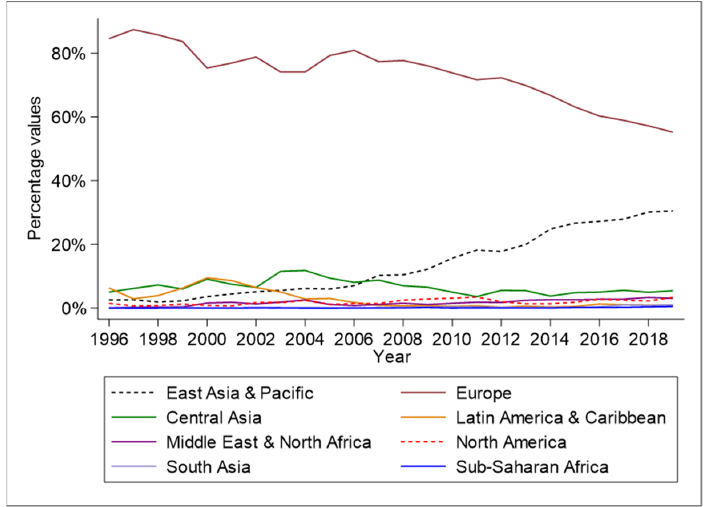
Figure 5. Russian non-renewable energy export values by region (1996–2019). Source: Authors’ elaboration based on data retrieved from CEPII database.